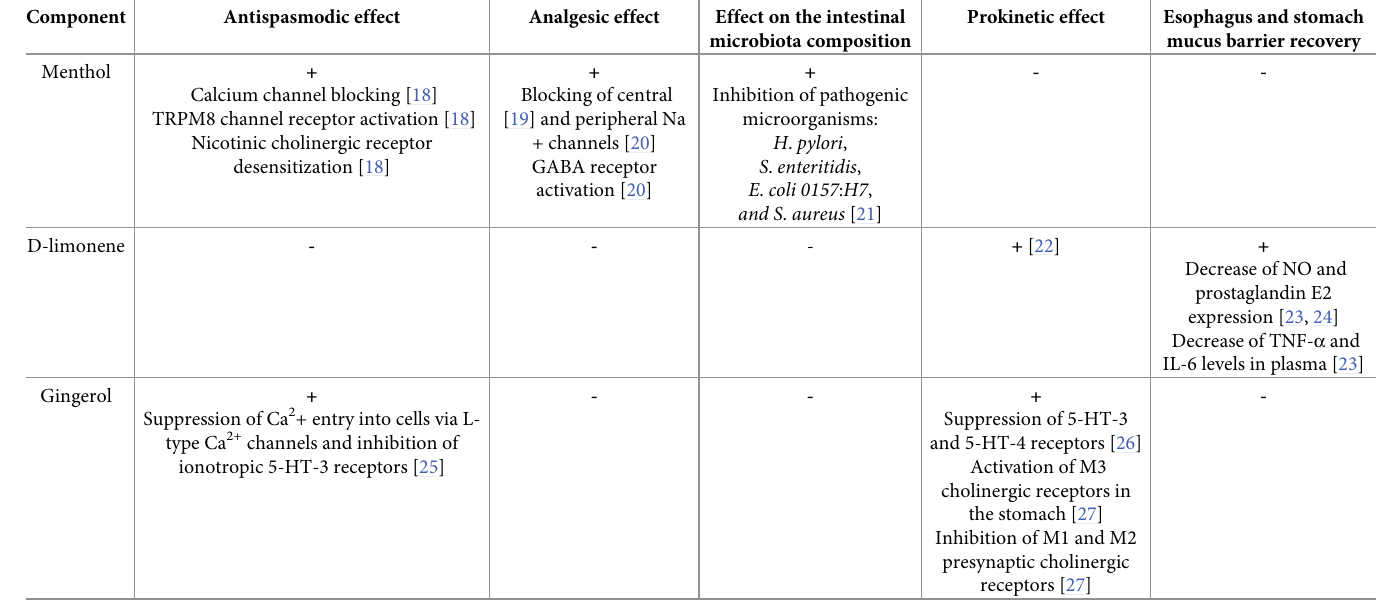
Table 1. Components of the supplement and their mechanisms of